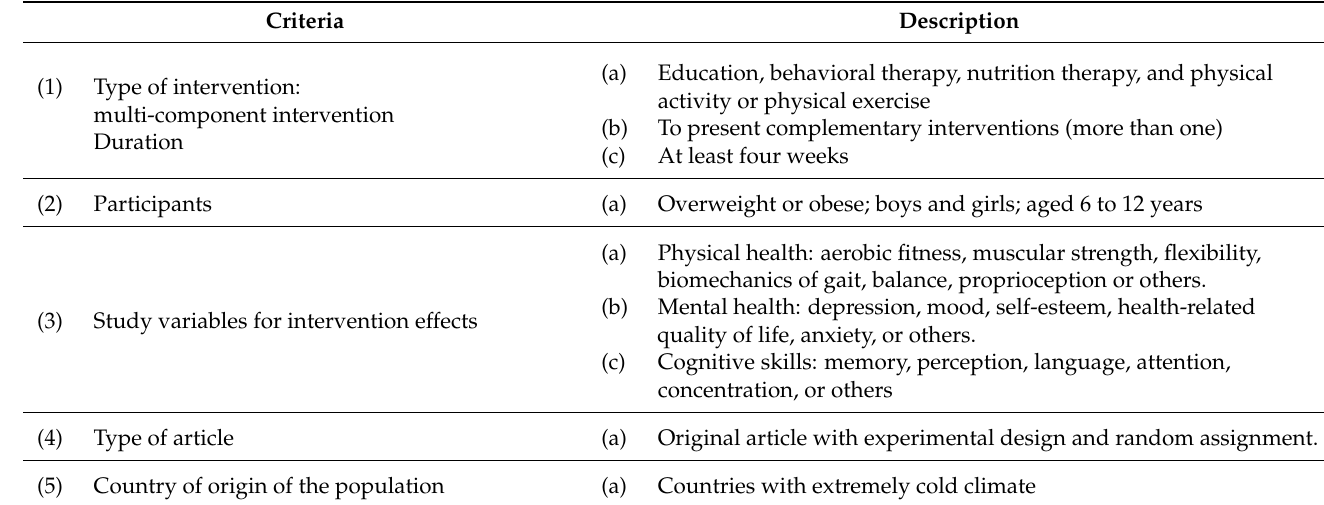
Table 1. Eligibility criteria of the